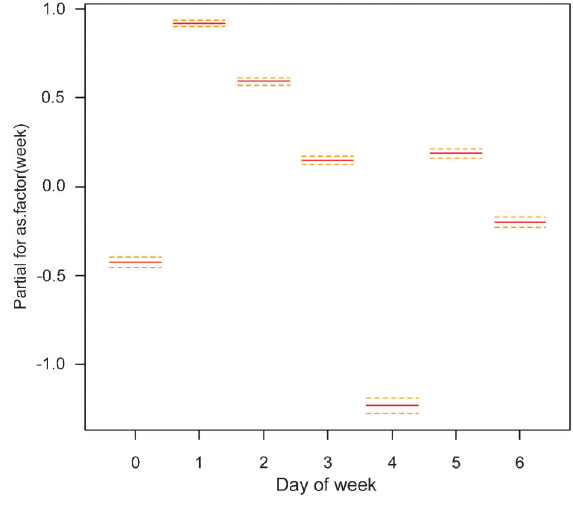
Figure 6. Atmospheric pressure effect graph (4 degrees of freedom).